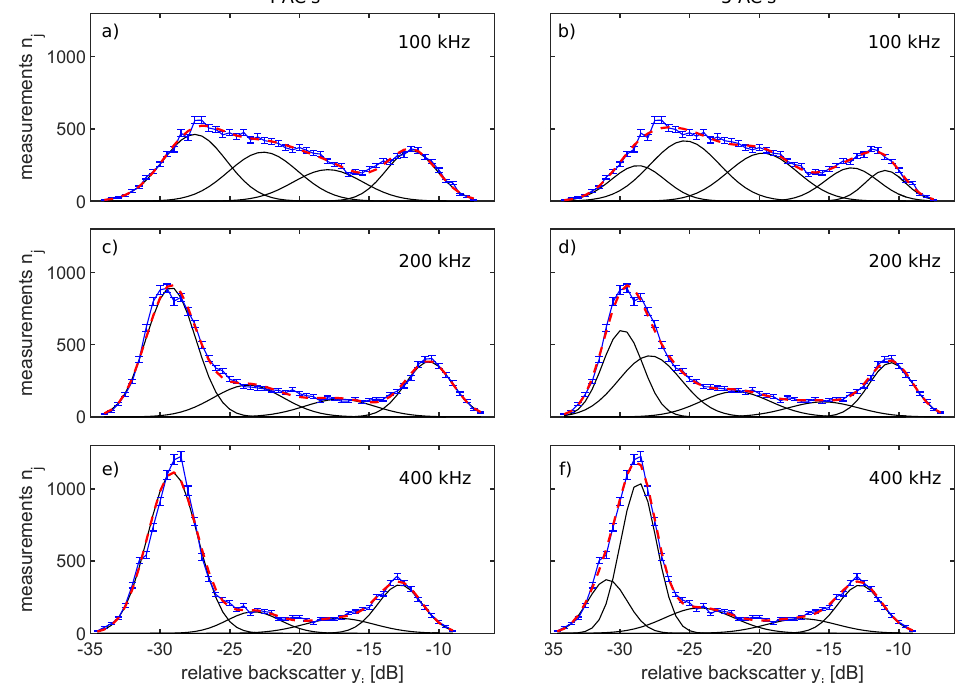
Figure 7. Model fits to the histogram of the measured backscatter data n j (blue) per 0.5dB bin y j at ( a , b ) 100, ( c , d ) 200, and ( e , f ) 400 kHz are displayed. The measured backscatter data are obtained from the 54 ◦ incident angle of the starboard side from the Bedford Basin 2016 dataset. The blue error bars indicate the variance of the measurements per bin. The modeled f ( y j | x ) histogram calculated by using ( a , c , e ) 4 Gaussian distributions and ( b , d , f ) 5 Gaussian distributions is shown in red. The corresponding Gaussians are displayed in